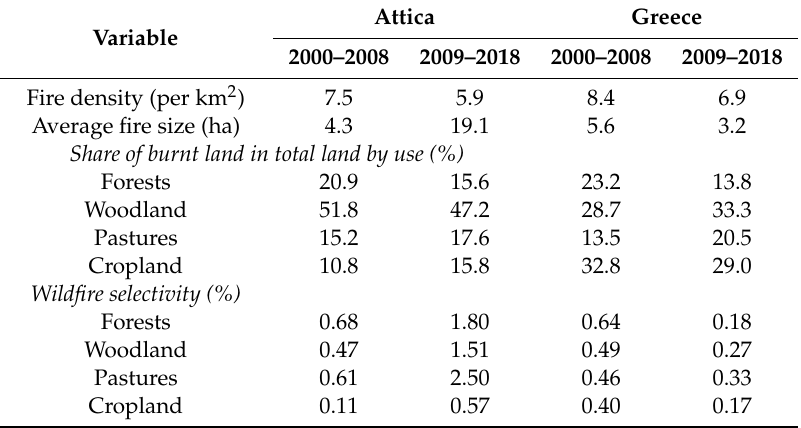
Table 2. Basic characteristics of wildfires in the study area by time interval. Source: own elaboration from o ffi cial statistics of the Hellenic Fire Brigade and Hellenic Statistical Authority.